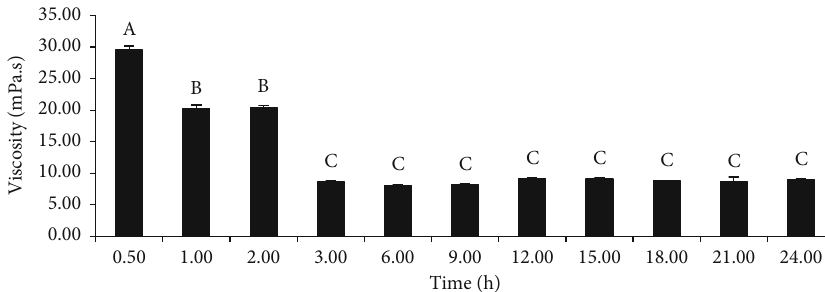
Figure 4: E ff ect of incubation time (h) on the viscosity (mPa.s) of Zn-amaranth puree lique fi ed with 1% (v/w) Viscozyme L at pH5 and 45 ° C. Data are expressed as the means ± standard deviations of triplicates. Means with the same letter in each column mean not signi fi cantly di ff erent ( p < 0 : 05 , ANOVA). Table 2: Properties of spray- and freeze-dried Zn-amaranth powders encapsulated with 10% (w/w) of di ff erent wall materials. Drying